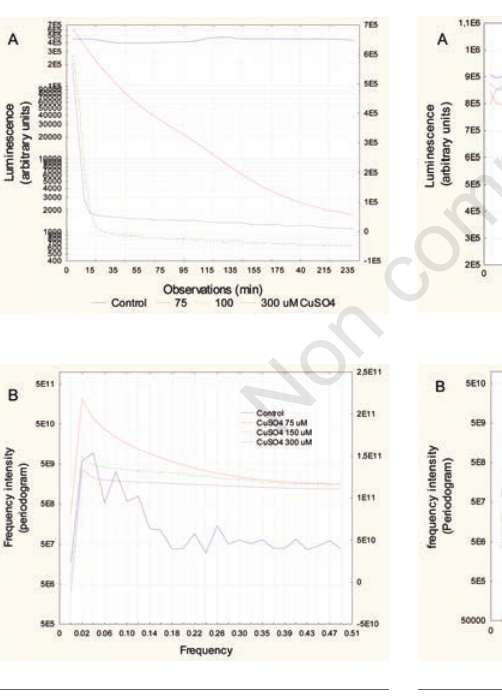
Figure 4. Change in luminescence over time in bacteria exposed to silver nanopar- ticles. Bacteria were re-suspended at 20 million cells/mL in 2% NaCl containing increasing concentrations of nanoAg. Luminescence was recorded at 5-min inter- vals for 3 h at 20°C under constant agita- tion. Recorded luminescence at each time (A) and frequency analysis by Fourier transformation (B) are